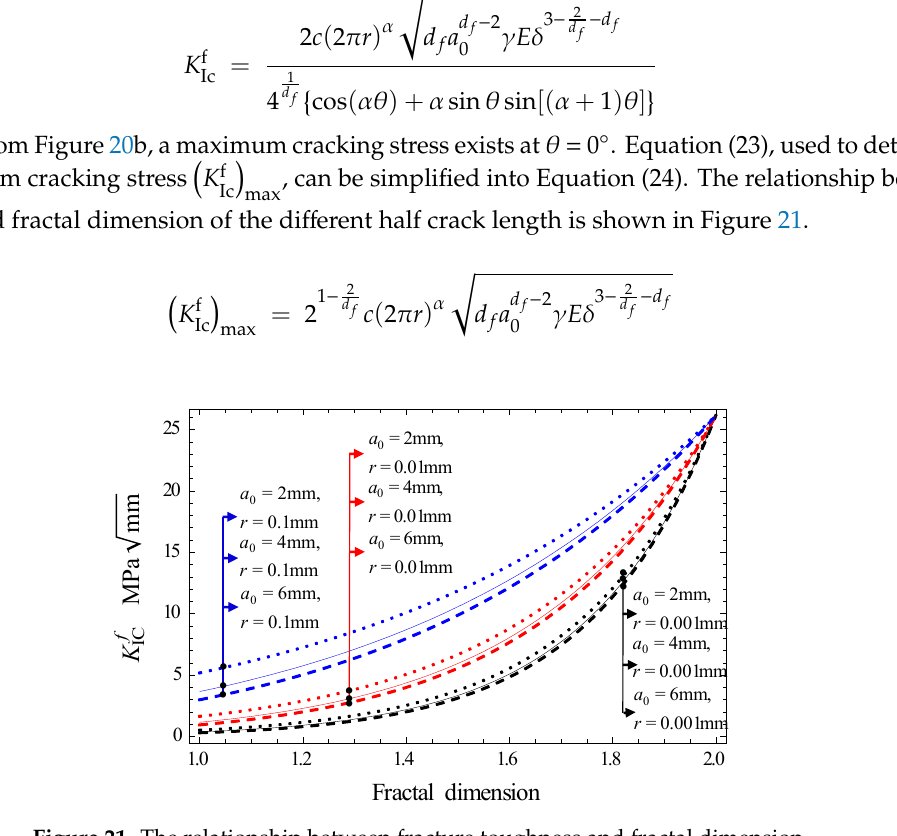
Figure 21. The relationship between fracture toughness and fractal Fig. 22 The relationship between fracture toughness and fractal dimension